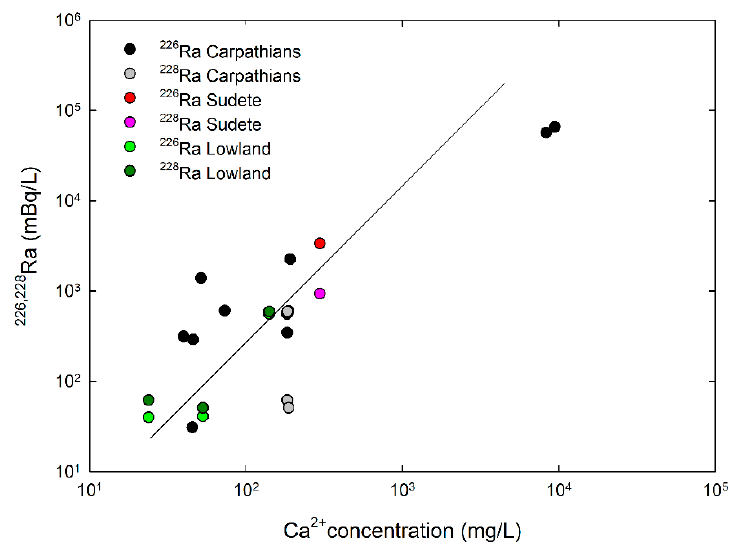
Figure 6. Relationship between radium content in Polish thermal waters and Ca 2+ concentration (excluding Cieplice C-1 and L ą dek-Zdój L-2).